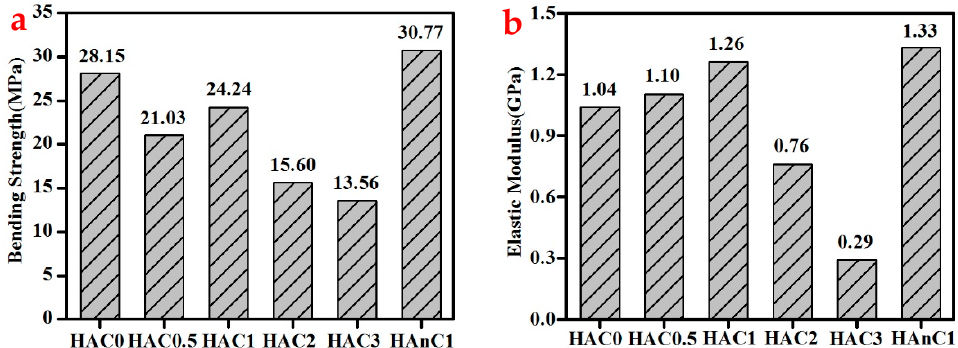
Figure 6. ( a ) Bending strength and ( b ) elastic modulus of CNTs/HA and nHA–CNTs/HA composites.